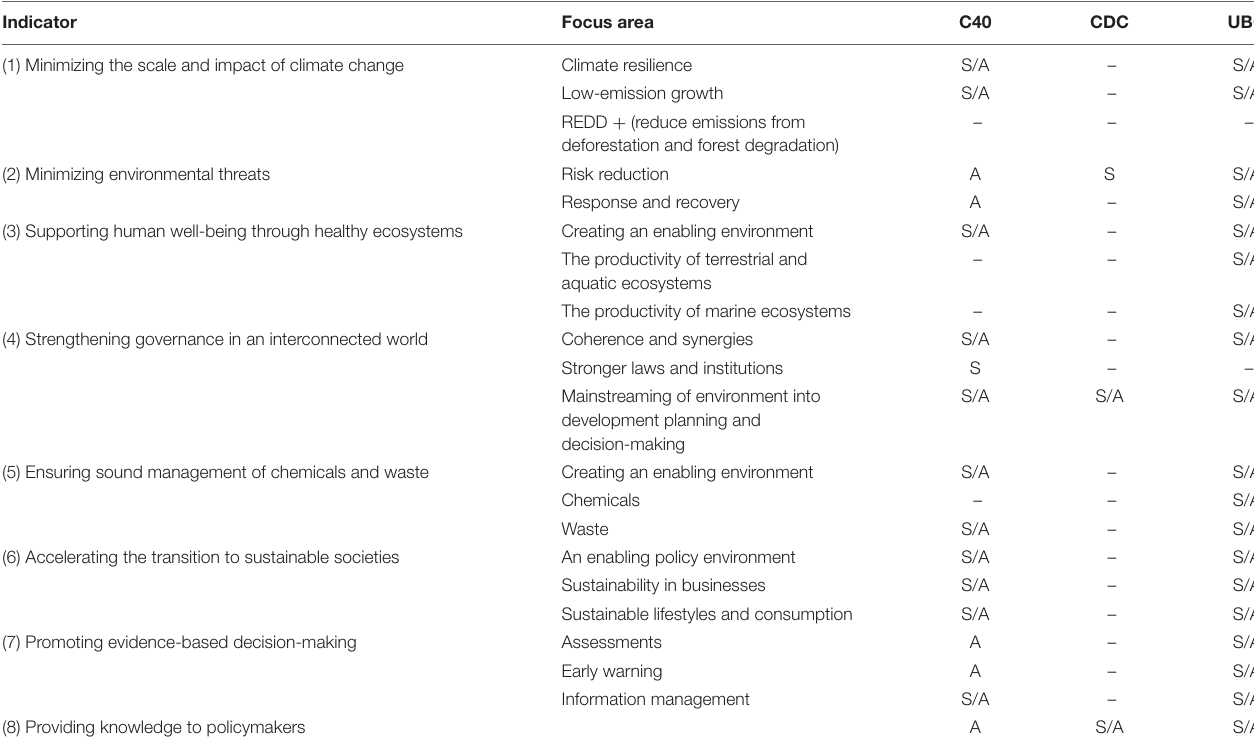
TABLE 5 | Networks and UNEP climate mitigation indicators 2 . Indicator